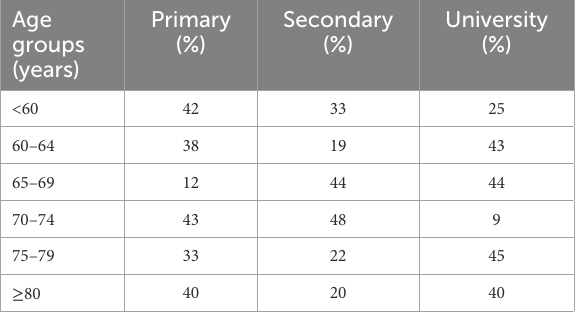
TABLE 2 Description of level of education between age